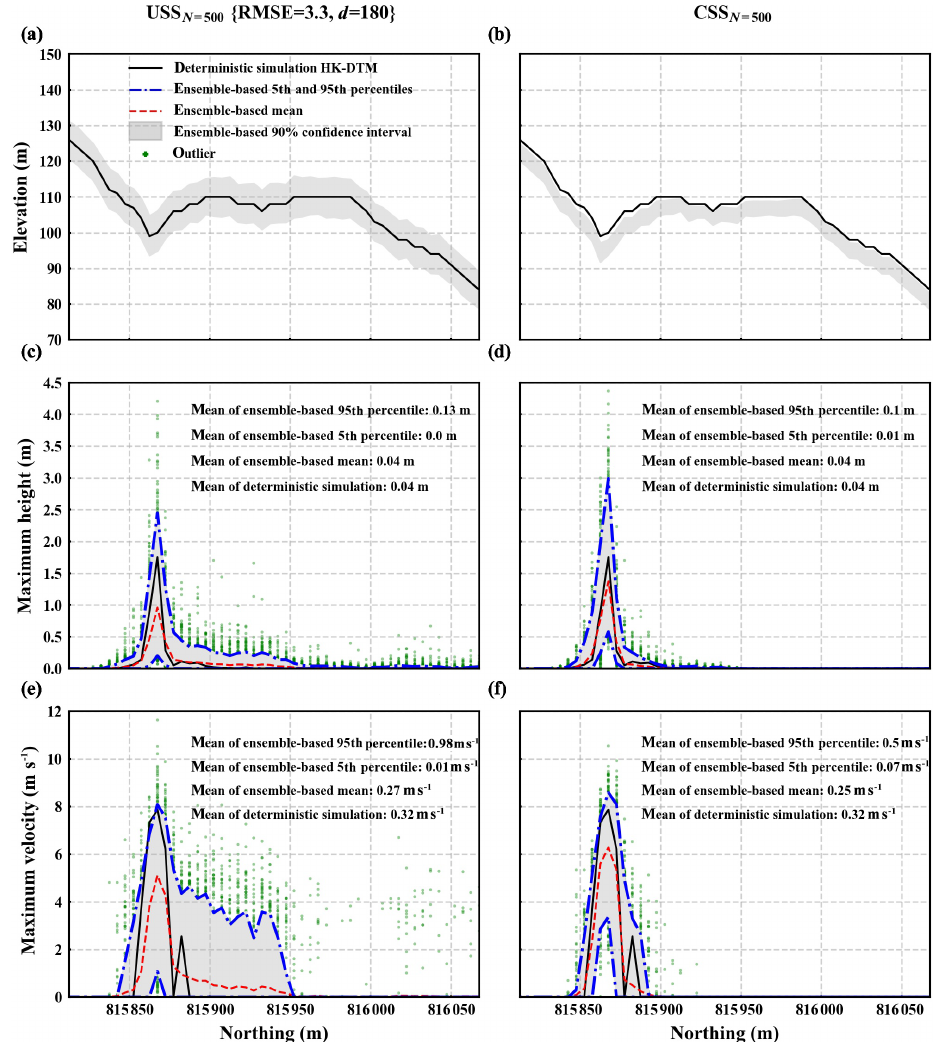
Figure 10. Elevation, maximum height, and maximum velocity at locations along the channel cross section (see Fig. 7b). Panels (a) , (c) , and (e) correspond to the USS N = 500 {RMSE = 3 . 3, d = 180} ensemble and panels (b) , (d) , and (f) to the CSS N = 500 ensemble. In each panel, dash-dotted blue lines represent ensemble-based 5th and 95th percentiles of the quantity. The dashed red line represents the ensemble-based mean of the quantity. The black line denotes corresponding results of the deterministic simulation. Annotated mean values are an average of all the locations. Due to DEM uncertainty, flow material of both ensembles tends to spread out along the channel cross-section direction. The ensemble-based mean of flow dynamic properties at the channel bottom location is smaller than flow dynamic properties at the channel bottom location of the deterministic simulation (compare peak value of dashed red line with peak value of black line). The more the flow material spreads out, the smaller the ensemble-based mean of flow dynamic properties at the channel bottom location (compare results of the USS N = 500 {RMSE = 3 . 3, d = 180} ensemble with those of the CSS N = 500